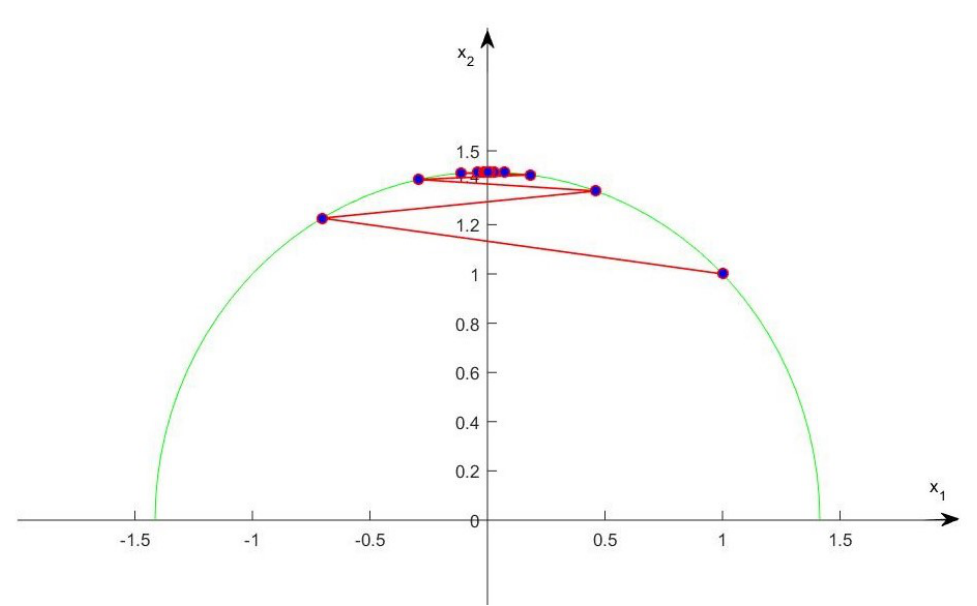
Figure 2. The approximation sequence for the initial estimation x 0 = ( 1,1 )